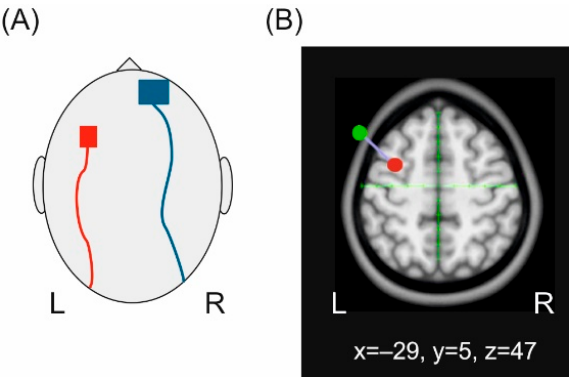
Figure 1. Transcranial direct current stimulation (tDCS). ( A ) Schematic illustration of the electrode positions. ( B ) Illustration of the tDCS-target area projected onto a standard brain. The red dot indicates the area to be stimulated corresponding to left BA 6, the green dot the localization of the active electrode attached to the head.